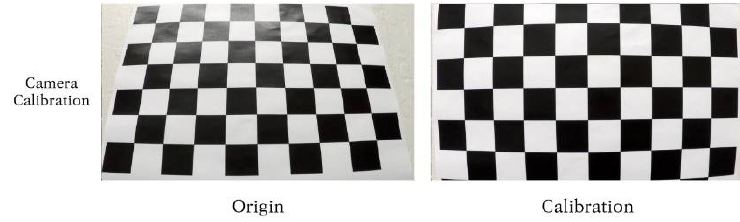
Figure 8. The process of distance estimation—camera calibration.